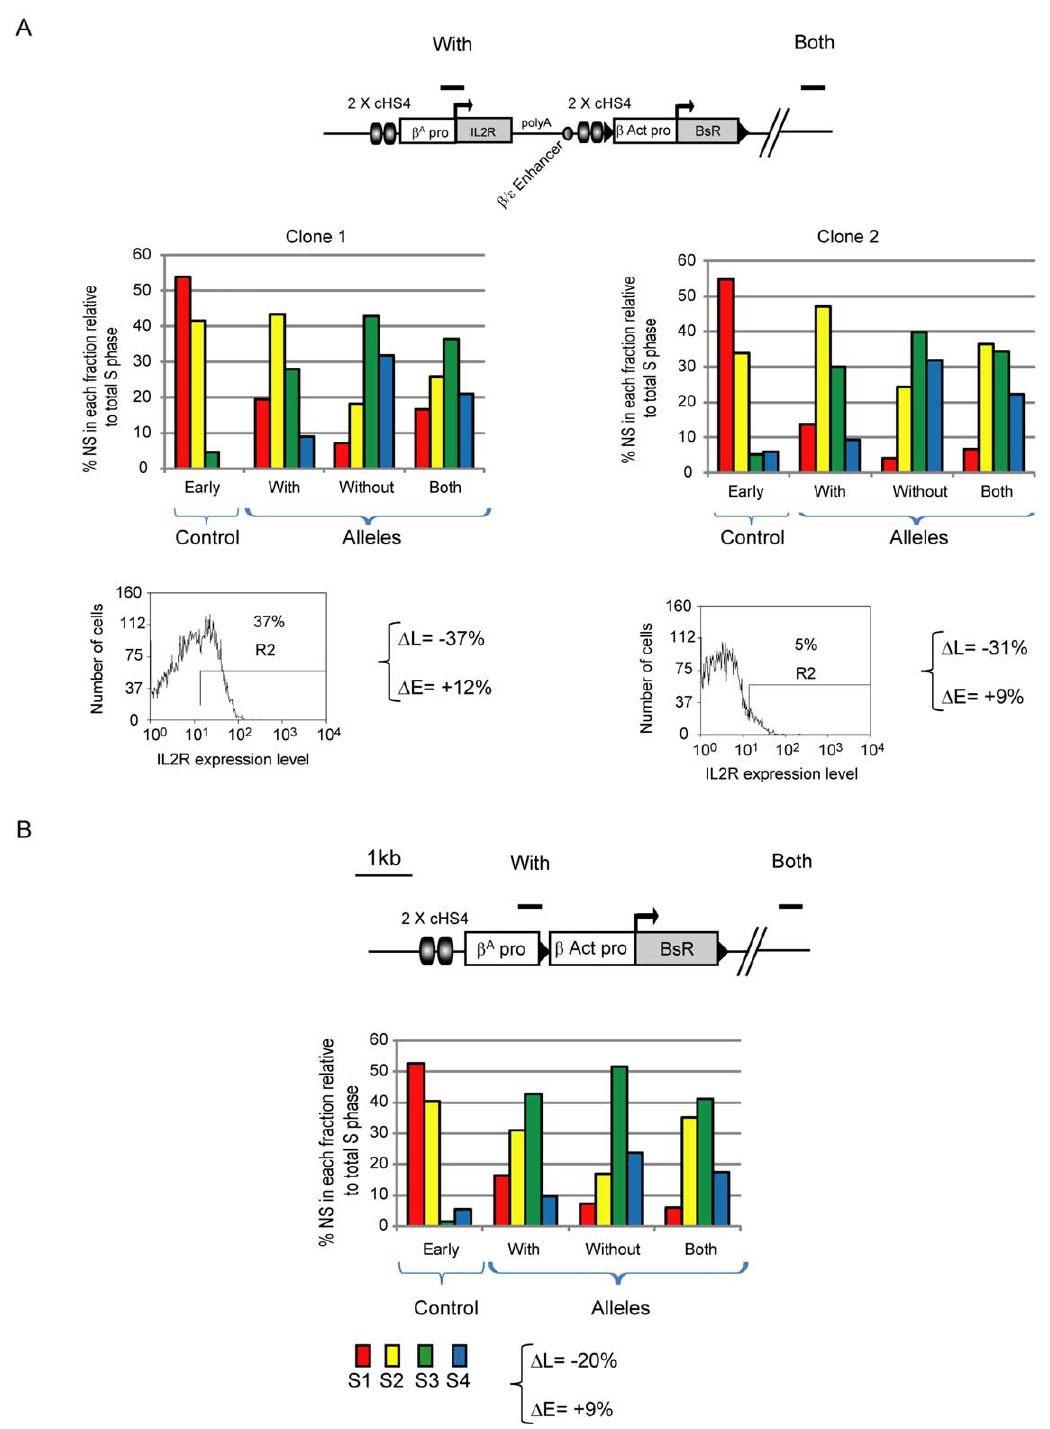
Figure 5. An origin flanked by HS4 insulator elements induces an important early replication shift. Replication timing profiles of DT40 chromosomal alleles following targeted integration of insulator containing transgenes. (A) Analysis of a transgenic line containing an IL-2R transgene flanked by two copies of the 275 bp HS4 insulator linked to the b -actin transgene. The IL-2R cDNA (grey rectangle) and the SV40 polyA signal were linked to the b A -globin promoter (white rectangle) and the b / e enhancer (grey oval). Flow cytometric analysis of IL-2R expression is shown below for the two transgenic lines (clones 1 and 2). The percentage of cells with fluorescence levels higher than control cells (R2) are indicated. (B) Analysis of a transgenic line containing two copies of the 275 bp HS4 insulator upstream of the b A -globin / b -actin transgene described in Figure 4B.